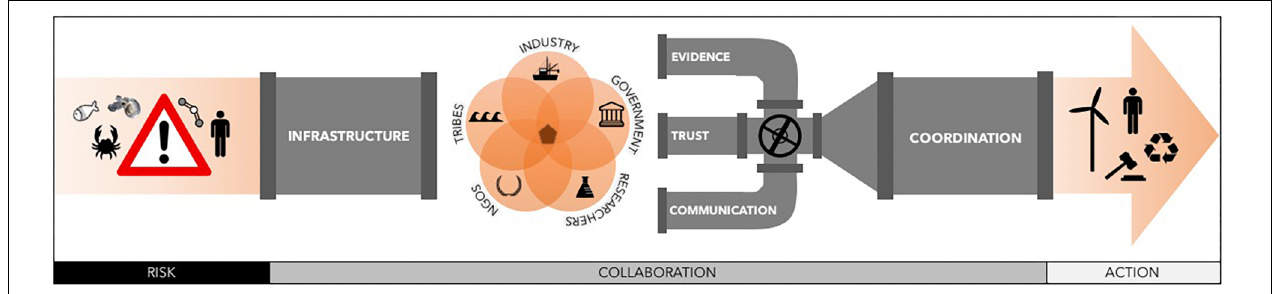
FIGURE 1 | Stages in the Knowledge-to-Action Pipeline. Information about risk is transferred through existing and amplified infrastructure to diverse stakeholders that all closely collaborate together. By building a body of evidence, mutual trust, and consistent communication practices, these bodies can coordinate to produce actions.